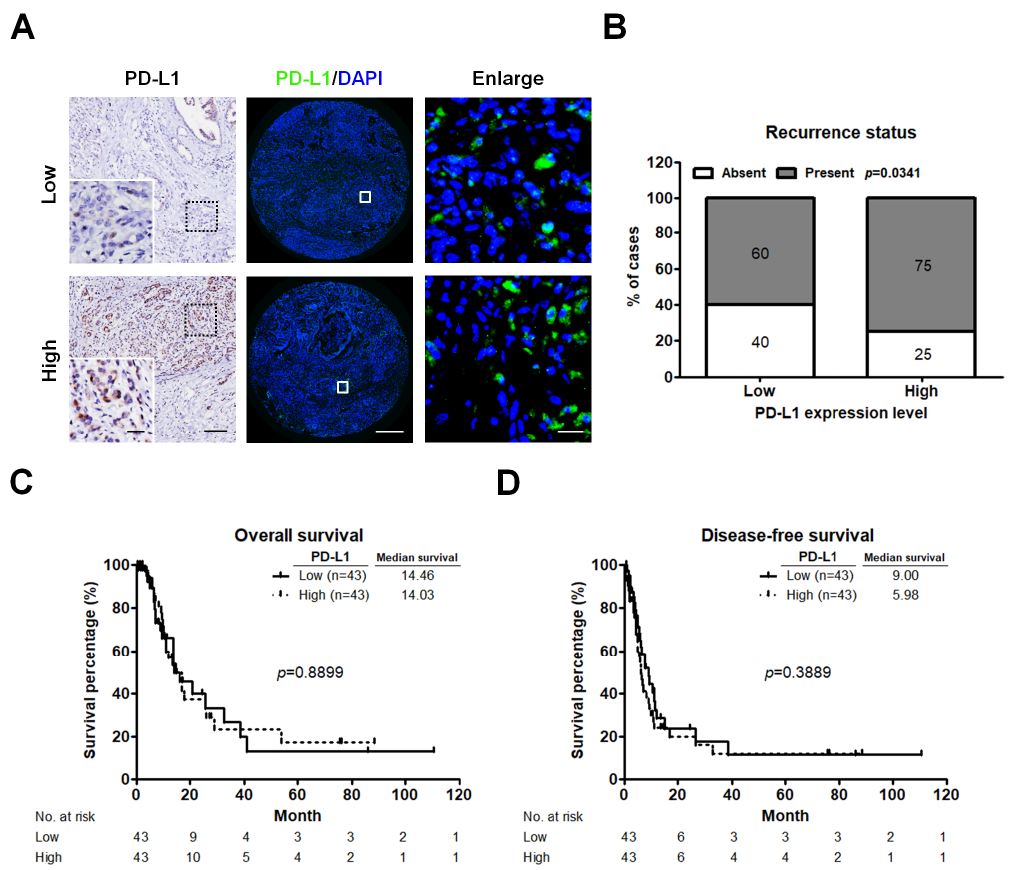
Figure 2. PD-L1 expression associates with patients’ recurrence status. ( A ) IHC and IF images displaying low and high level of PD-L1 staining in PC tumors. IHC staining (left panel) of PD-L1 is shown as brown colored sections. Original magnification, 20×; scale bars, 100 μm. Enlarged images on the left lower panel are shown for the areas outlined by black squares. Scale bars show 25 μm in length. IF staining (middle panel) of PD-L1 in TMA cores from two different PC tumors. Green indicates PD-L1 staining. The nuclei were stained by 4′,6-diamidino-2-phenylindole (DAPI, bule). Enlarged images on the right panel are shown for the areas outlined by white squares in middle panel. Scale bars show 20 μm in length. ( B ) Relative distribution analysis of PC patients’ recurrence status within low ( n = 43) or high PD-L1 expression group ( n = 43). Absent, patients without recurrent PC; present, patients with recurrent PC. p values calculated using Chi-square test. ( C , D ) Survival analysis of PC patients stratified by PD-L1 expression level using the Kaplan-Meier estimator to determine the OS ( C ) and DFS ( D ). p values determined using the log-rank test. OS, overall survival; DFS, disease-free survival.